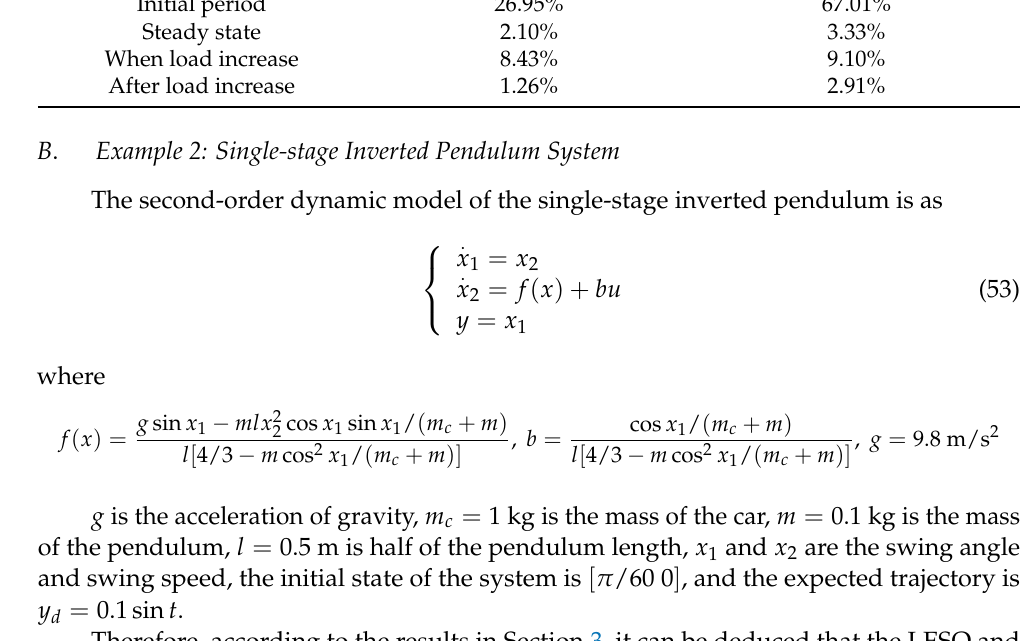
Table 2. THD performance comparison of different methods.